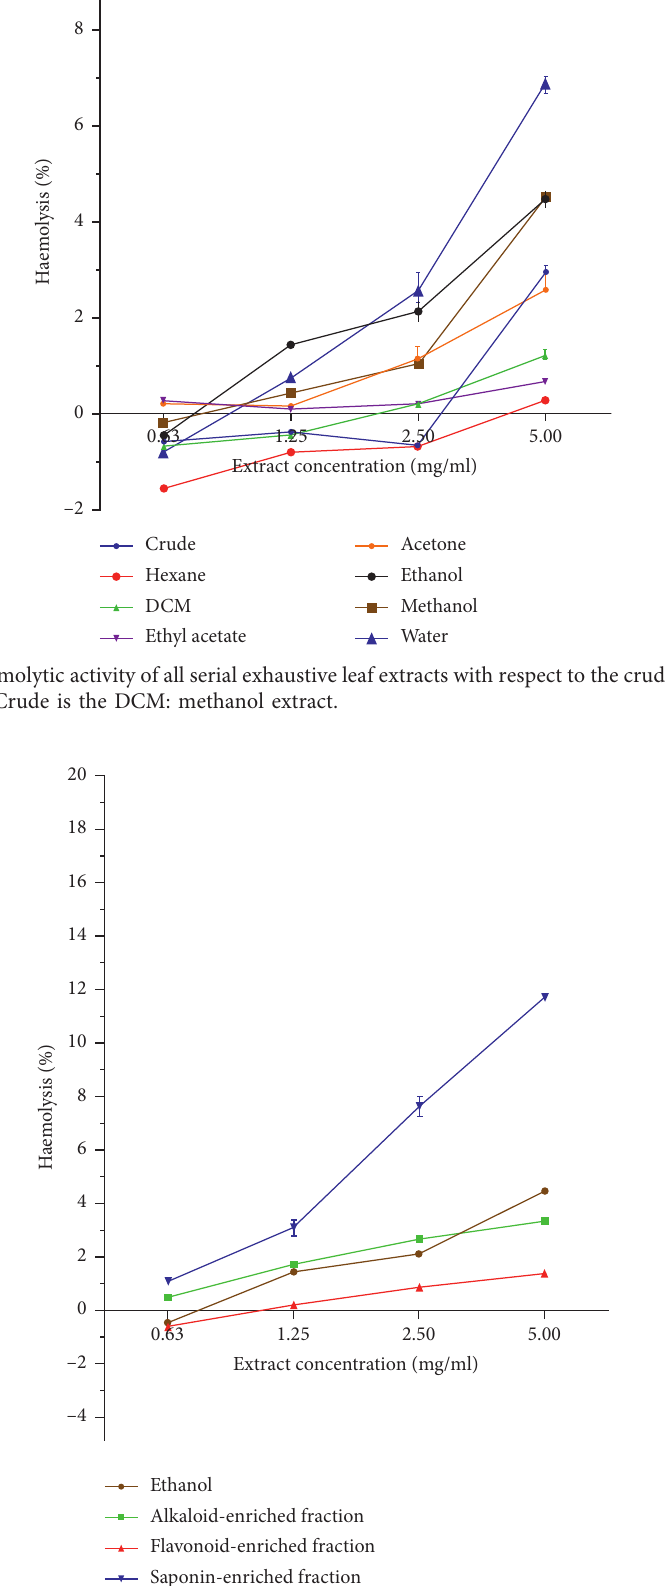
Figure 5: Comparison of the haemolytic activity of phytochemical-enriched fractions with respect to the ethanolic extract from which they were obtained. The saponin-enriched fraction exhibited the highest